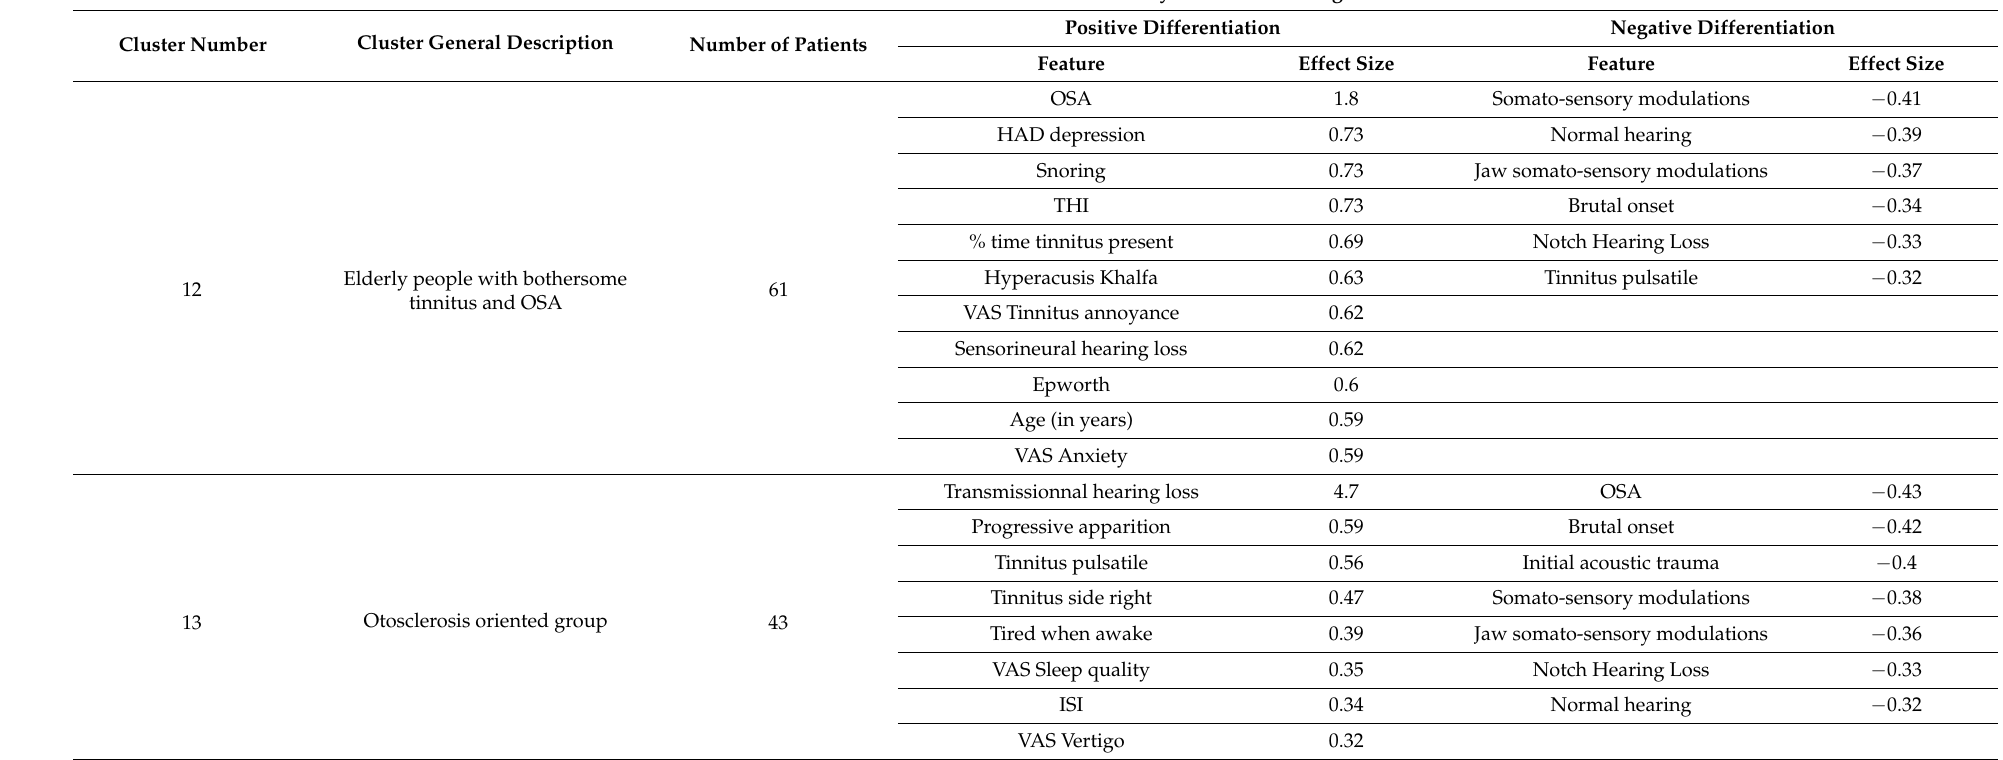
Table 7. Cont. Individual Clusters Characteristics of the Finally Selcted